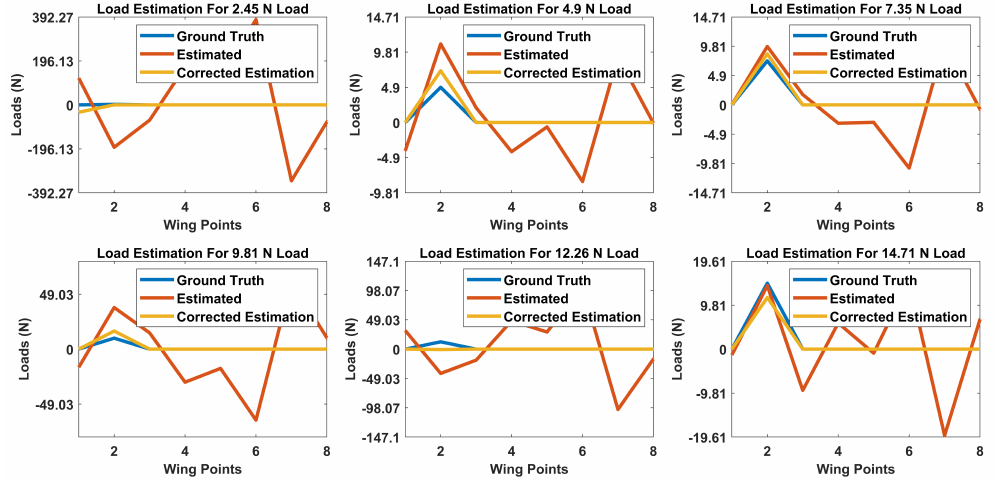
Figure A3. Corrected load estimations for concentrated loads acting at point 2 of the